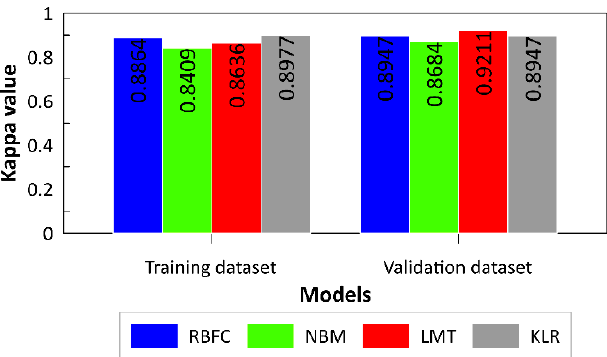
Figure 5. Kappa values of the models.